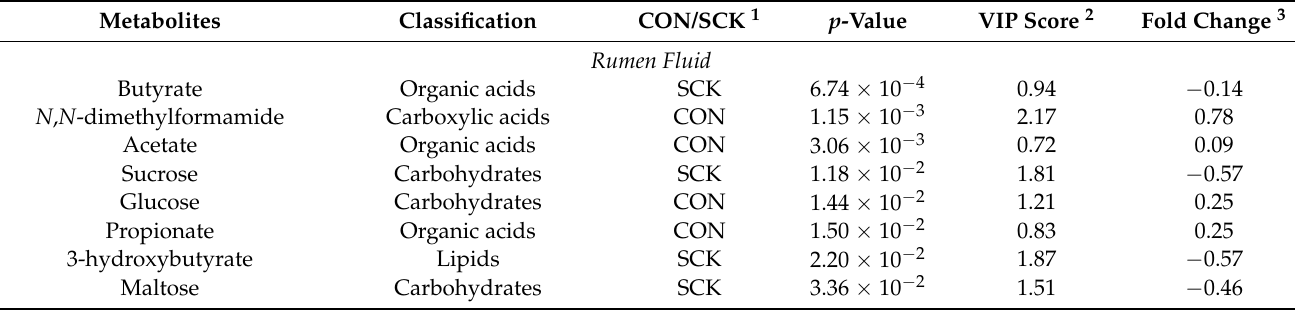
Table 3. Differential enrichment of metabolites content of rumen fluid and milk between healthy and subclinical ketosis groups.